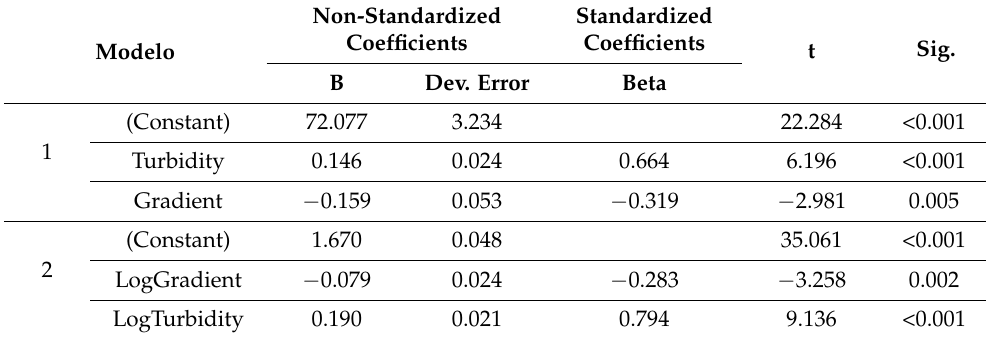
Table 11. Standardized and non-standardized regression function coefficients for HTF